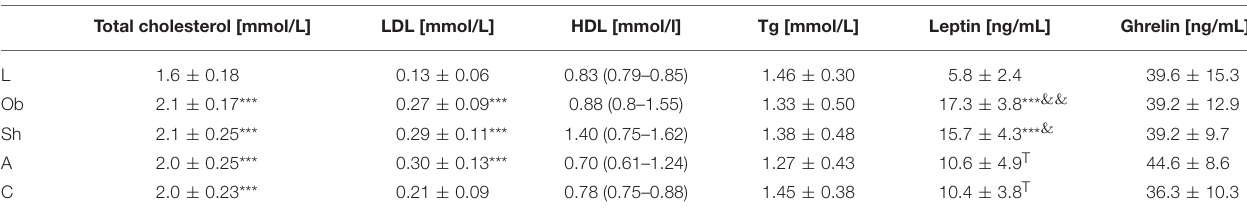
TABLE 2 | The effects of high-calorie diet (Ob vs. L) and stimulation procedure (Sh vs. A vs. C) on serum total cholesterol [mmol/L], LDL [mmol/L], HDL [mmol/L], triglicerydes (Tg) [mmol/L], serum leptin [ng/mL] and serum ghrelin [ng/mL] concentrations. Total cholesterol